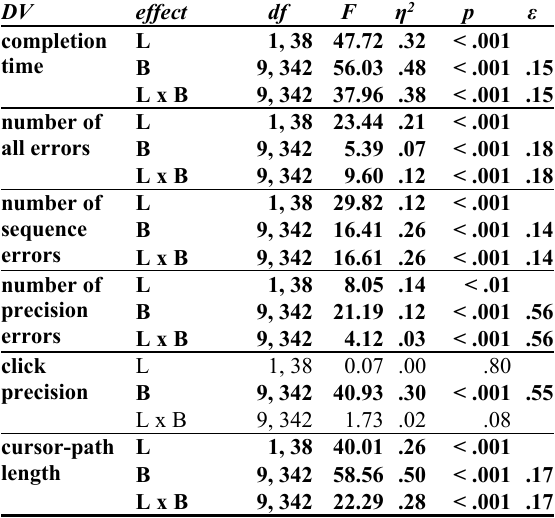
Table 3. ANOVA results of the learning phase of Experiment 2.